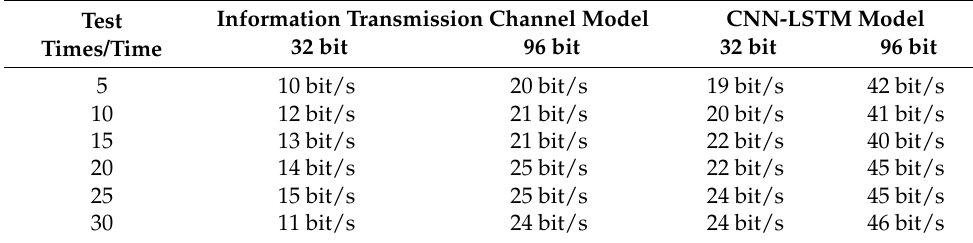
Table 2. Multiplexing rates of two